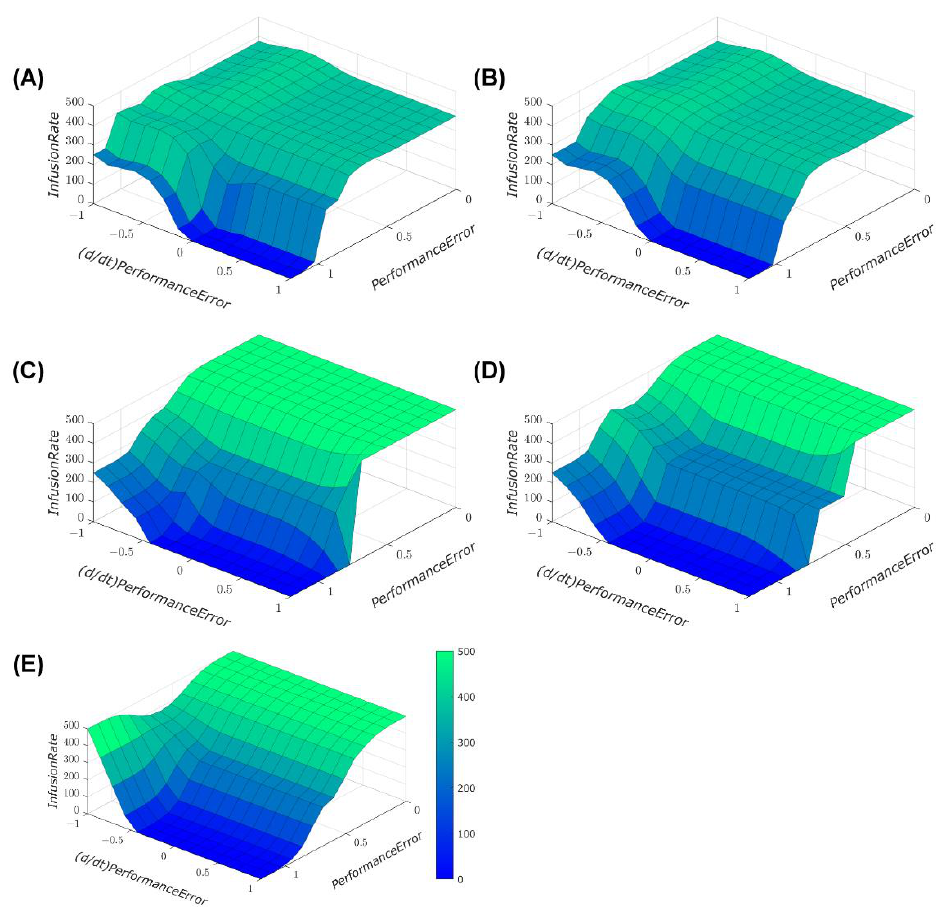
Figure 3. Rule surface plots for dual-input fuzzy logic controllers 1 ( A ), 2 ( B ), 3 ( C ), 4 ( D ), and 5 ( E ).